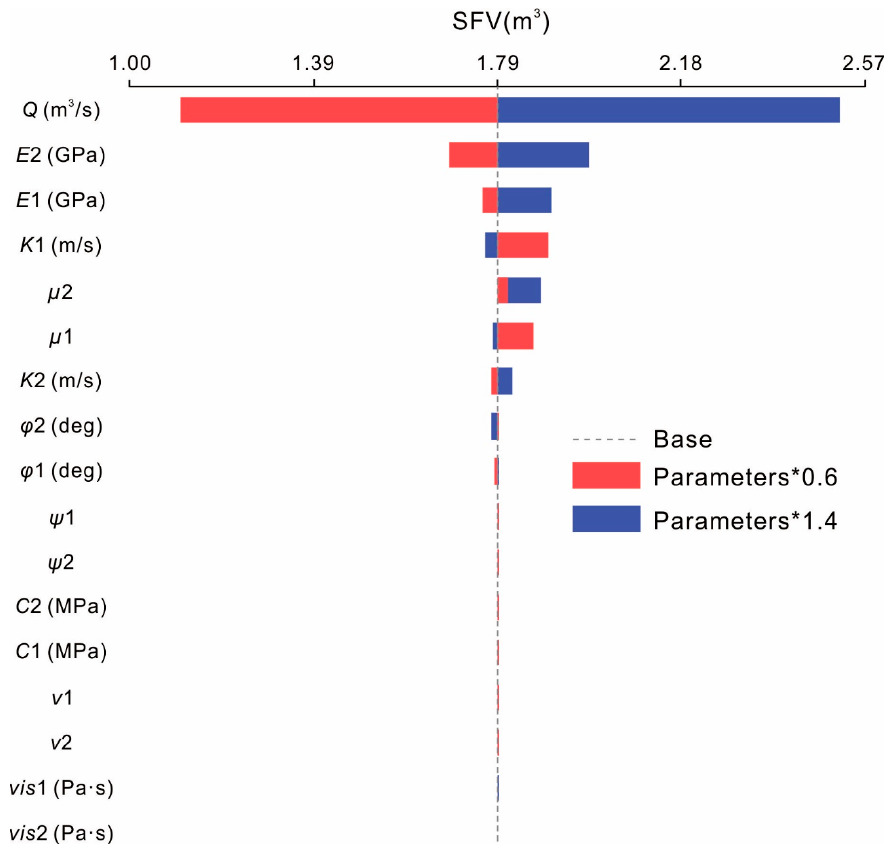
Figure 7. Hurricane analysis results for SRV. Indicators of the model are divided into high, medium, and low levels (140%, 100%, and 60%). The dotted gray line in this figure refers to the result of the benchmark model.